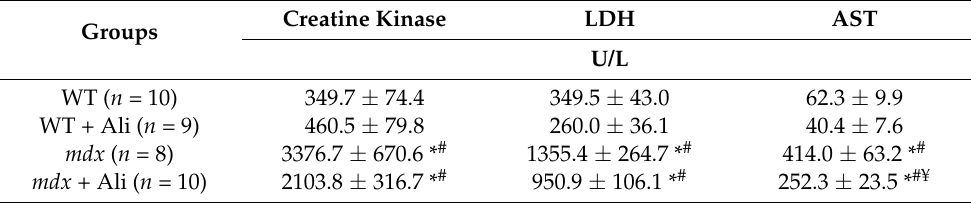
Table 2. The level of creatine kinase, LDH and AST in the serum of experimental groups of mice.